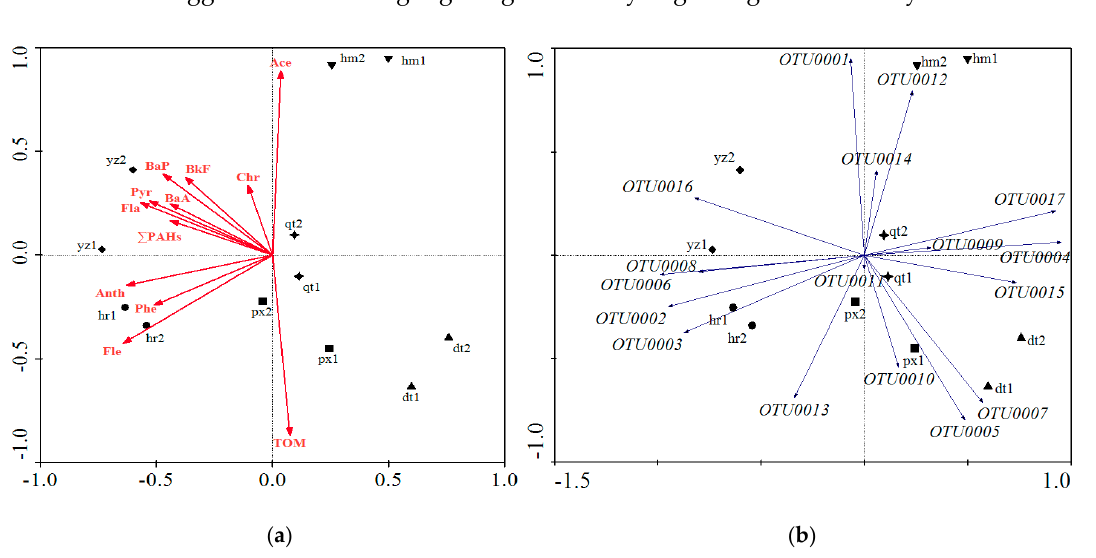
Figure 6. Redundancy analysis showed the correlation between bacterial consortia and soil environment factors ( a ) and some frequent OTUs of phylum Proteobacteria ( b